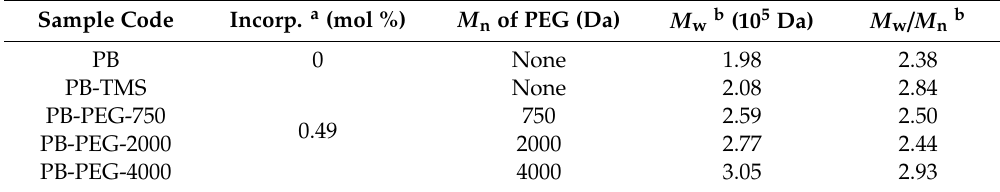
Table 1. Molecular characteristics of the homopolymer, copolymer, and PEG-grafted copolymers. Sample